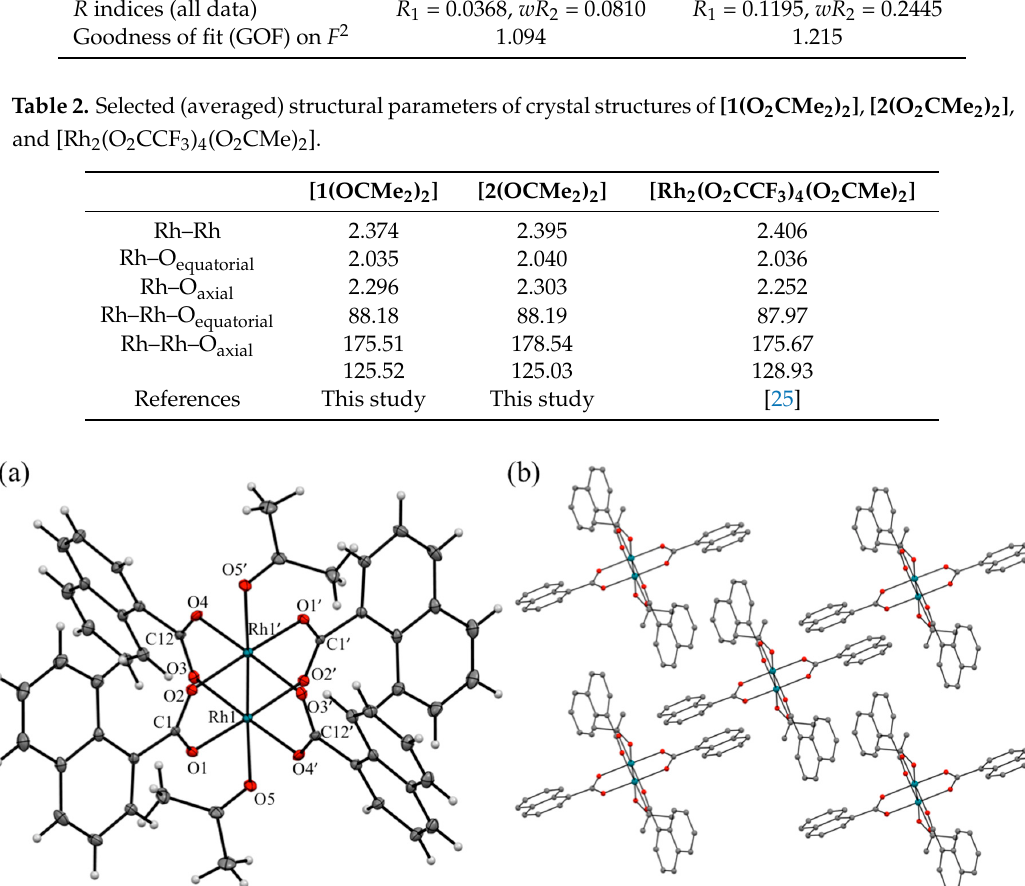
Figure 2. ( a ) ORTEP diagram (thermal ellipsoid: 30%); and ( b ) expanded surrounding structure of [1(OCMe 2 ) 2 ] crystal. In ( b ), hydrogen atoms are omitted for clarity.